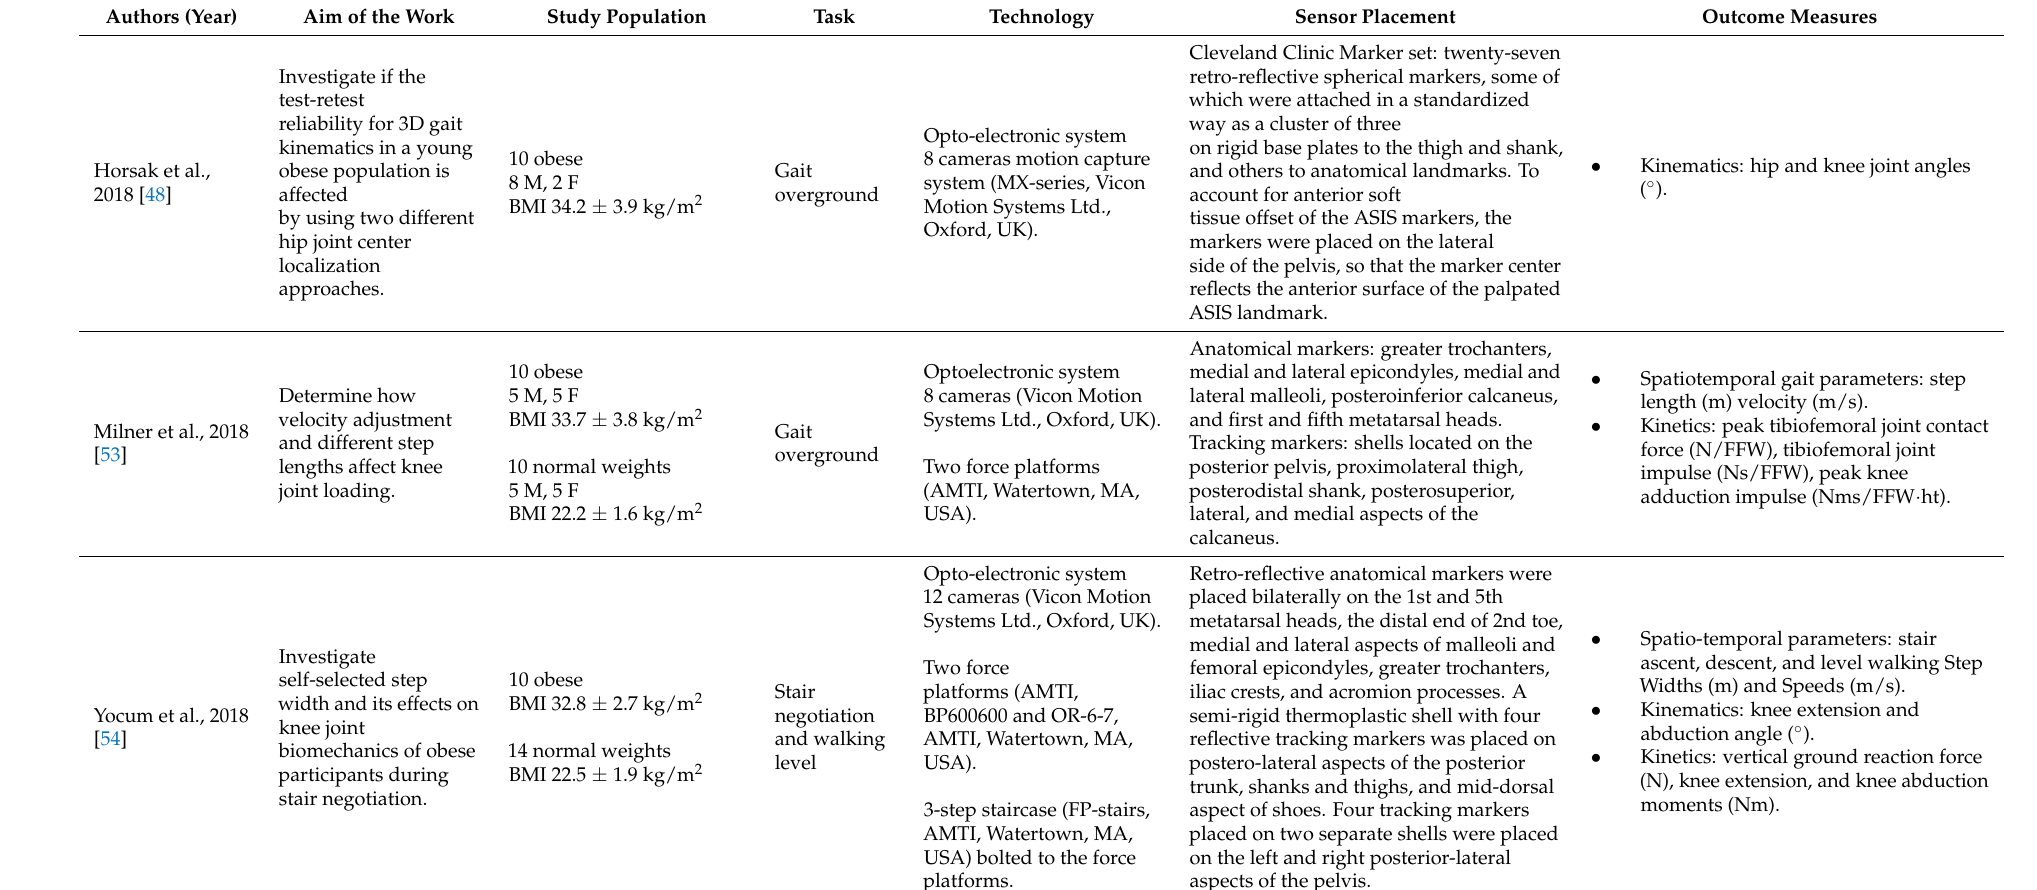
Anatomical markers: greater trochanters, medial and lateral epicondyles, medial and lateral malleoli, posteroinferior calcaneus, and first and fifth metatarsal heads. Tracking markers: shells located on the posterior pelvis, proximolateral thigh, posterodistal shank, posterosuperior, lateral, and medial aspects of the